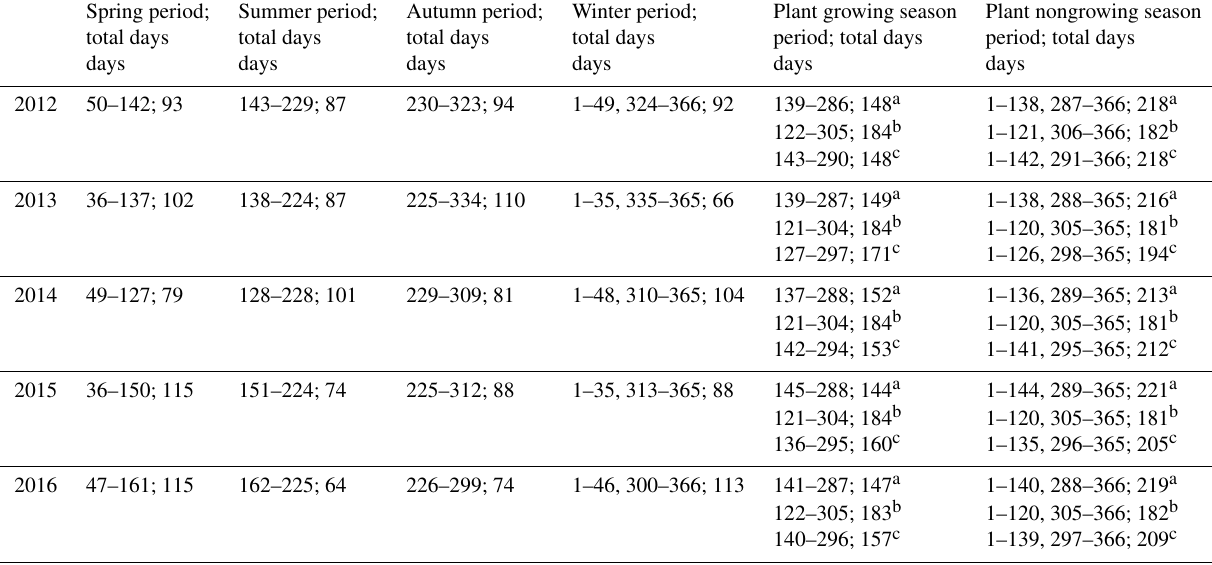
Table 2. Measurements of four seasons from 2012 to